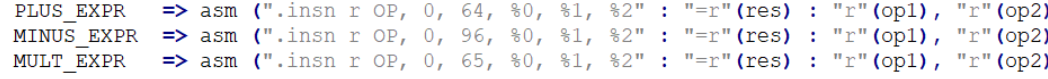
Figure 10. Replaced assembly statements for XADD, XSUB and XMUL in GIMPLE.